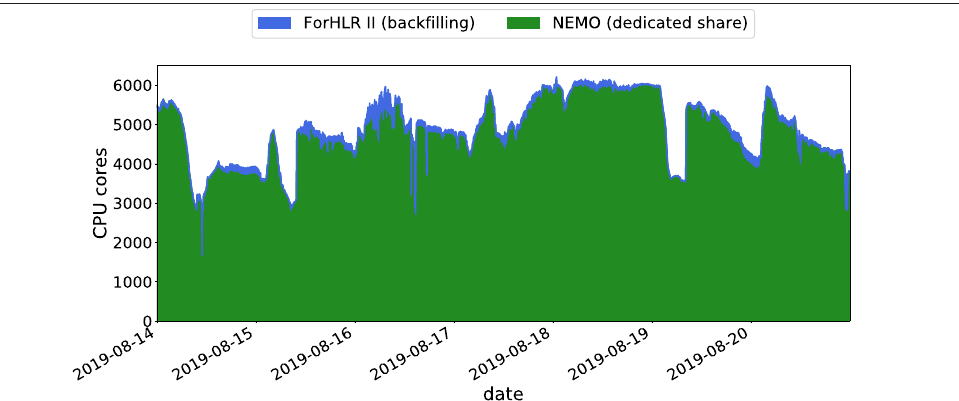
Figure 4. Opportunistic resources allocated at NEMO HPC cluster in Freiburg and the ForHLR II HPC cluster at